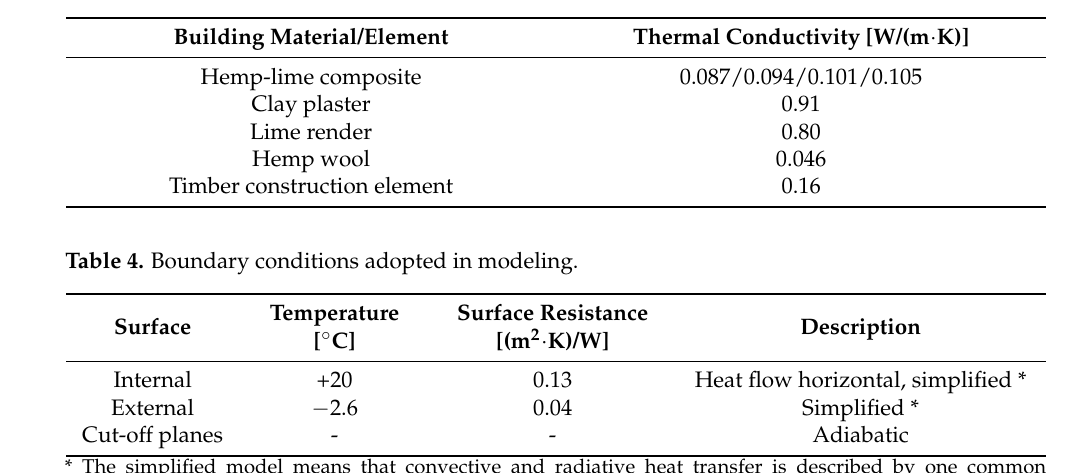
Table 3. Thermal conductivity of building materials and elements.